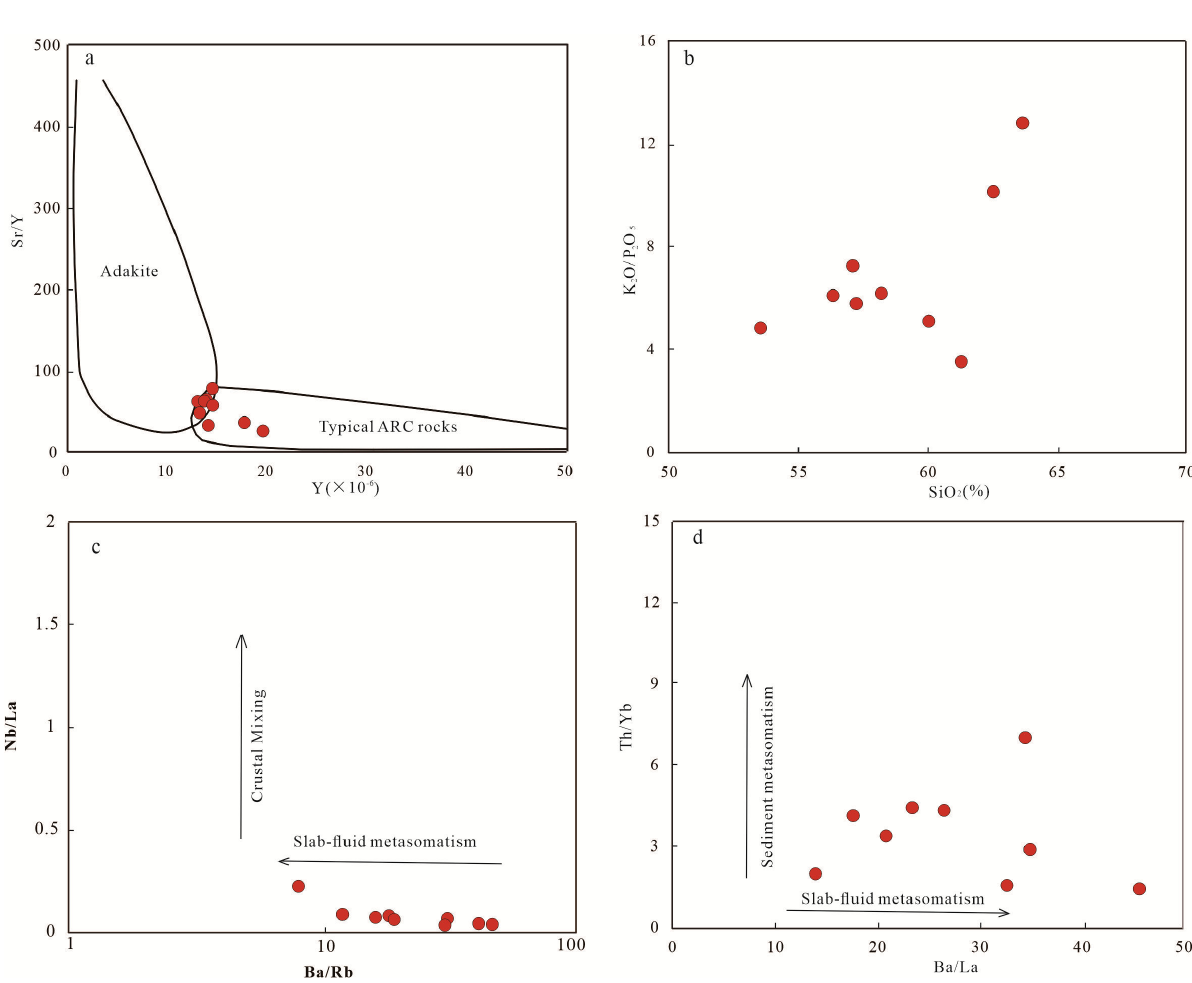
Figure 9. ( a ) Sr/Y vs. Y diagram (modified after Defant and Drummont [59]). ( b ) K 2 O/P 2 O 5 vs. SiO 2 diagram (modified after Ji et al. [4]). ( c ) Nb/La vs. Ba/Rb diagram. ( d ) Th/Yb vs. Ba/La diagram (modified Woodhead et al. [56]) for mafic volcanic in Badaguan area.